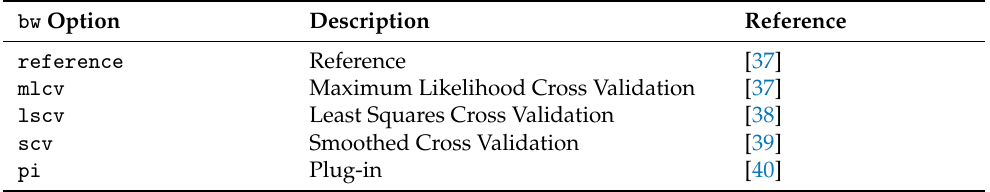
Table 1. Overview of the bandwidth selection options in Srho.ts .